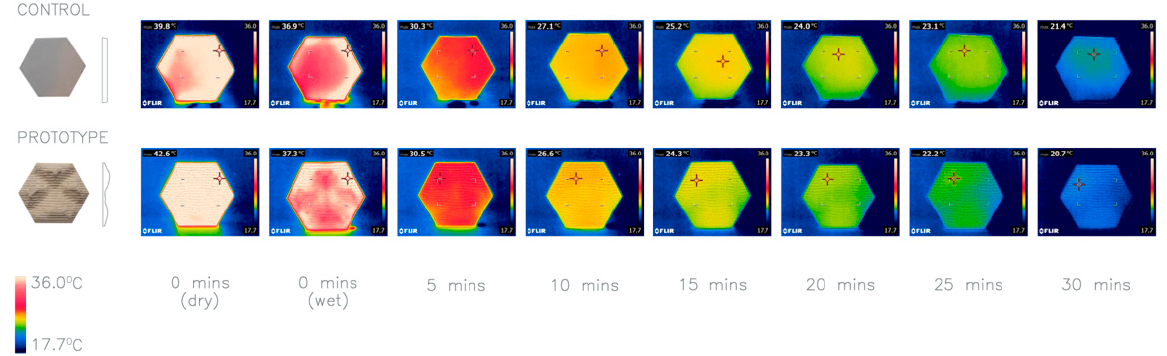
Figure 15. Thermal imaging of a prototype with P1 compared with a plane panel. Average heat loss after 30 min: Control 20.23 °C, Prototype 21.9 °C.